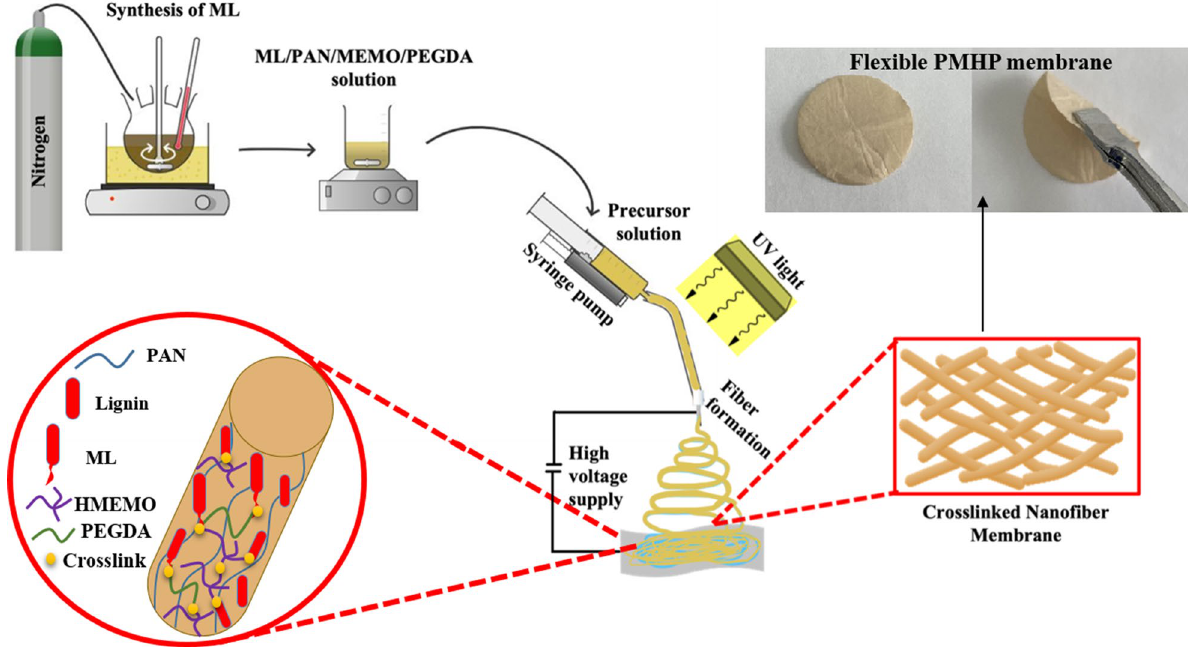
Figure 2. Schematic representation of PMHP membrane via UV-electrospinning technique.